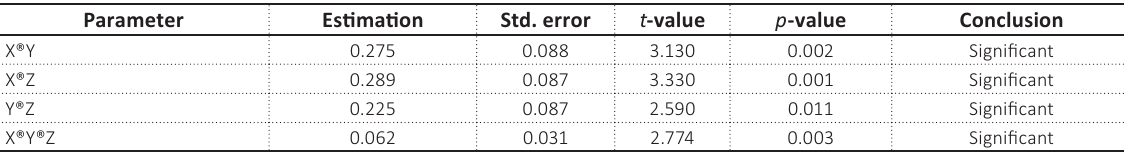
Table 4. Influence parameter estimation of in-store promotion on customer value and its influence on purchase